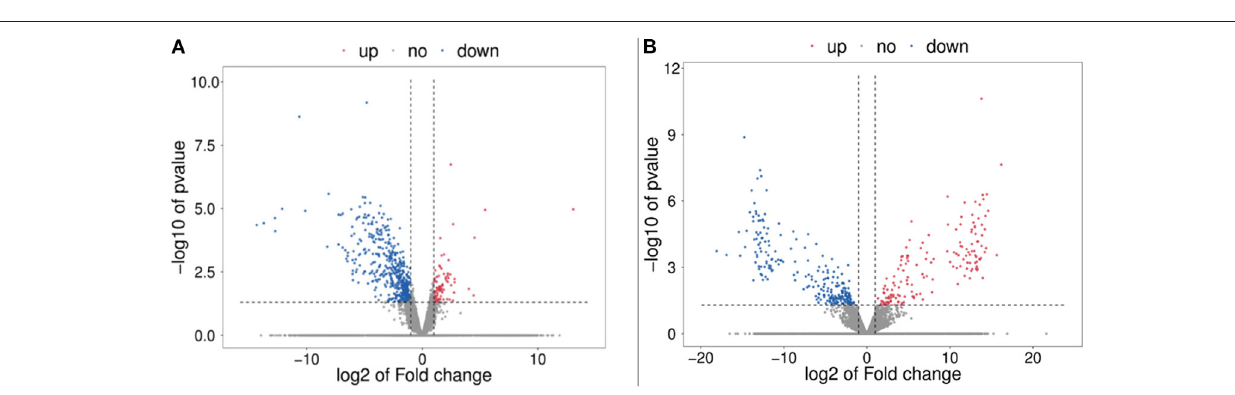
Frontiers in Veterinary Science |